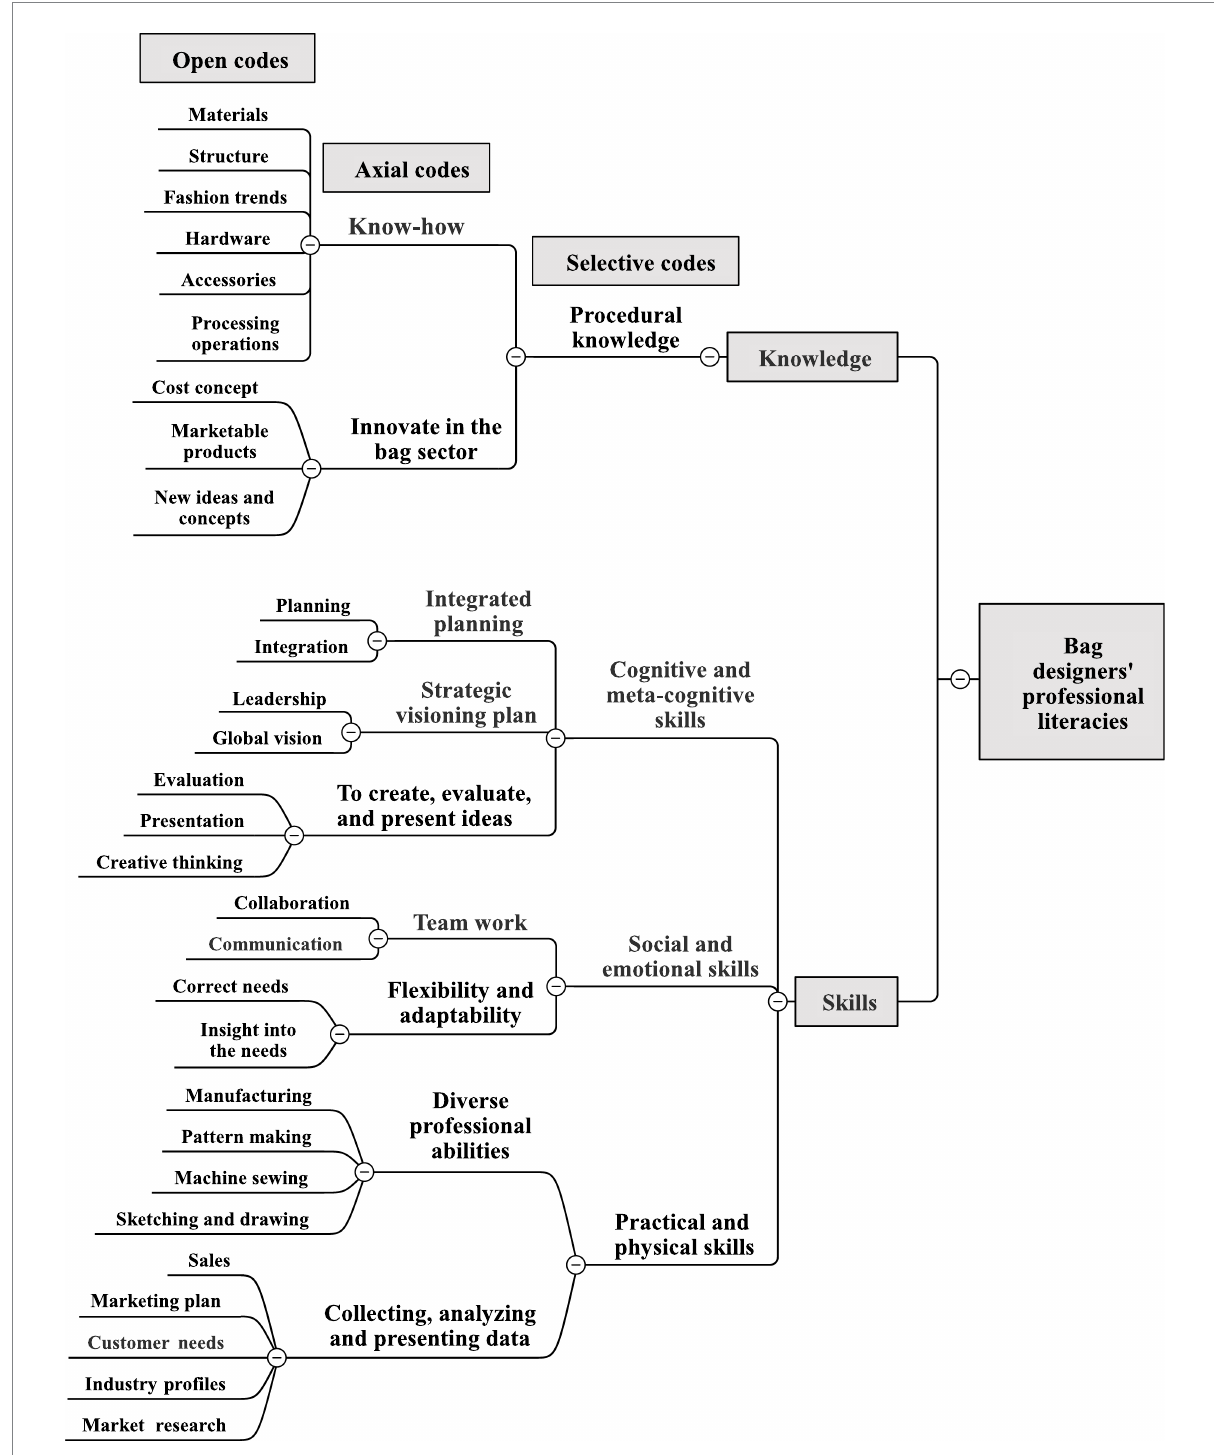
FIGURE 2 Bag designers’ professional literacies